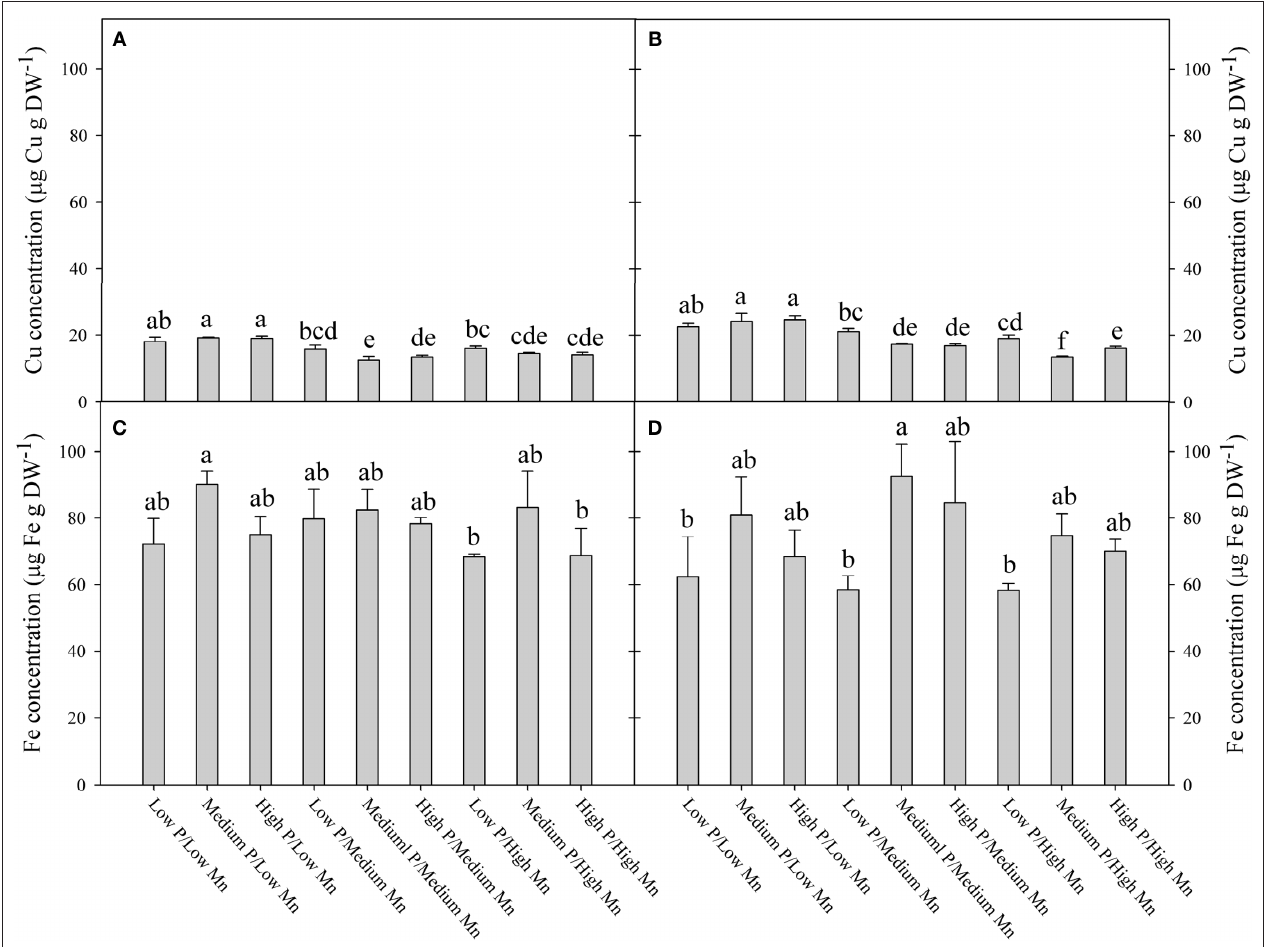
FIgure A1 | The concentration Cu (A,B) and Fe (C,D) in the youngest fully emerged leaf of the Mn-inefficient genotype Antonia (A,C) and Mn-efficient genotype Vanessa (B,D) grown in hydroponics at different Mn and P levels. Different letters above columns mark significant differences between treatments ( P > 0.05). Data are means ± SE ( n